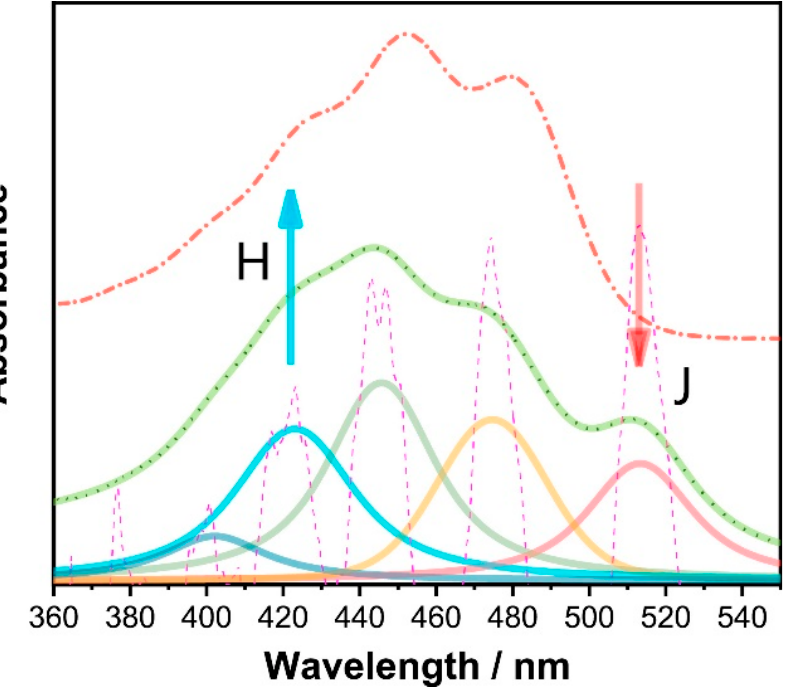
Figure 2. Absorption spectra of beta carotene aggregates in 1:1 aqueous ethanol (dot) and in pure ethanol (dash dot). Dash line represents the negative second derivative of the experimental results. Coloured lines are the Voigt fitting components and their sum (green) (Reprinted with permission from Ref. [54]. 2022, Elsevier).